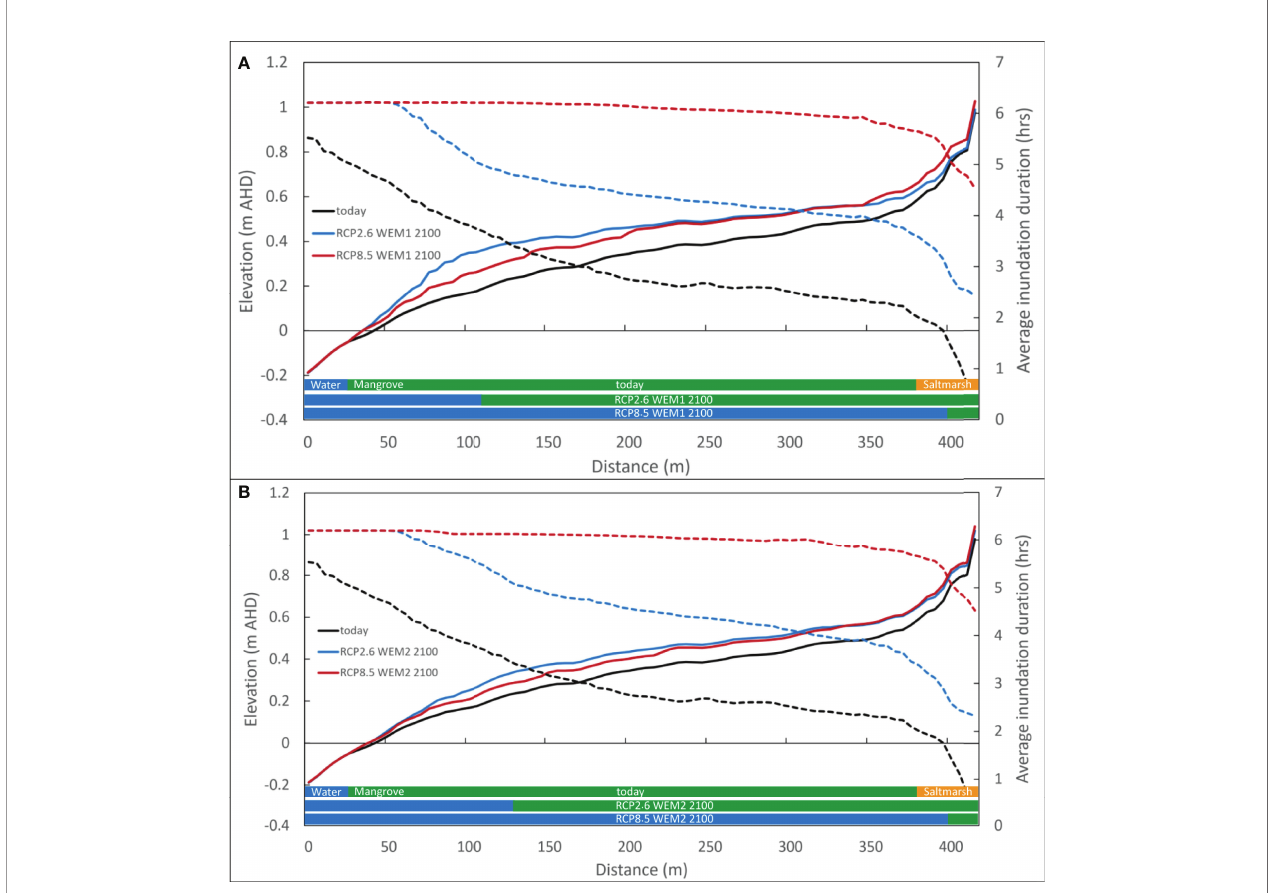
FIGURE 7 | Topographic changes in response to SLR for a selected intertidal wetland transect (see Figure 3 for location) as of today (black), for the simulation of the low SLR (blue) and high SLR (red), as well as WEM Linear 1 (panel A ) and Linear 2 (panel B ). Blue, green and orange bars at the bottom of each panel indicate wetland vegetation con fi gurations resulting from changing wetland inundation regimes under the different scenarios. Dashed lines represent the simulated average inundation duration (per event) corresponding to each